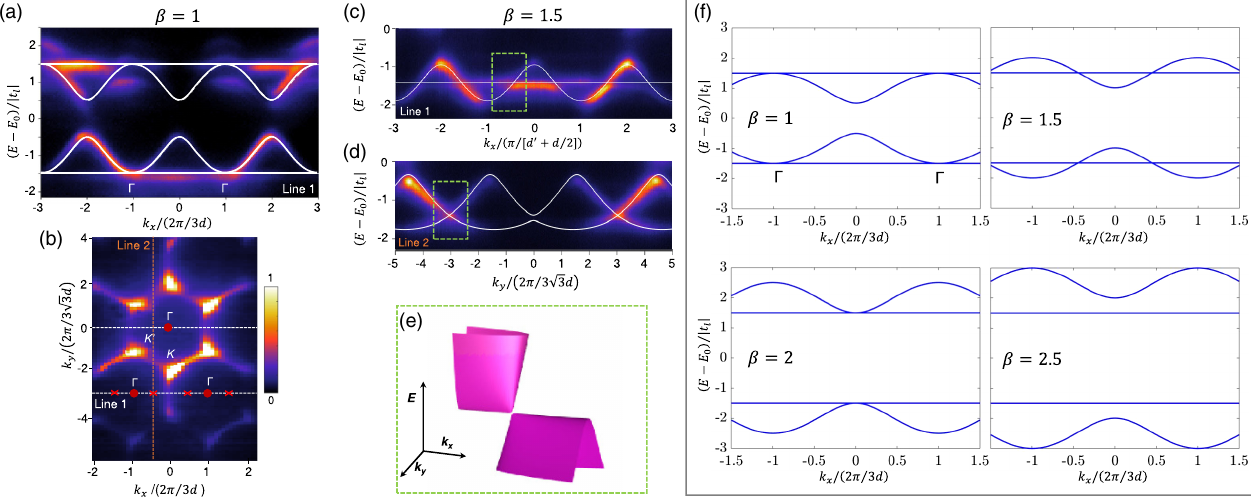
FIG. 5. Type-III Dirac cones. (a) Measured photoluminescence intensity for β ¼ 1 (micropillar diameter: 2 . 60 μ m, ffiffiffi p ¼ − 2 π = ð 3 ¼ − 0 . 85 meV. (b) Emission d ¼ d 0 ¼ 2 . 40 μ m) along k d Þ [line 1 in panel (b)]. Here, E 0 ¼ 1 . 5687 eV and t for k x y L in momentum space at E 0 for β ¼ 1 , showing the usual Dirac points at the high-symmetry points in reciprocal space. Crosses indicate the position of the type-III Dirac points reported in panel (c). (c) Zoom of the low-energy section of the measured spectrum for a lattice ¼ − 0 . 78 meV) showing the emergence of type-III Dirac cones combining flat and with β ¼ 1 . 5 ( d ¼ 2 . 40 μ m, d 0 ¼ 2 . 10 μ m, t L ¼ − ð 0 . 5 × 2 π Þ = 3 d [line 2 in panel (b)], crossing the Dirac point dispersive bands. (d) Measured dispersion along the k direction for k y x in the dashed rectangle in panel (c). (e) Dispersion obtained from the tight-binding model zoomed in the momentum space region marked with a dashed rectangle in panels (c) and (d). In panels (a), (c), and (d), the white lines show the tight-binding model. ffiffiffi p ¼ − 2 π = ð 3 ¼ 0 for β ¼ 2 . d Þ for different values of β > 1 . Type-III Dirac cones merge at k (f) Calculated dispersions for k y x